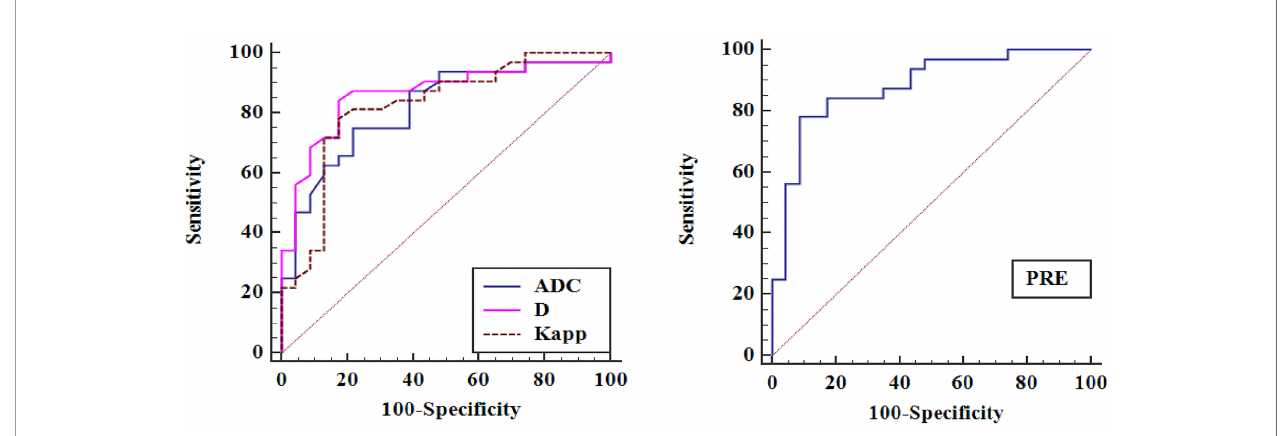
FIGURE 4 | Receiver operating characteristic curves (ROCs) for ADC, D, Kapp and PRE in distinguishing pulmonary malignant tumours from benign